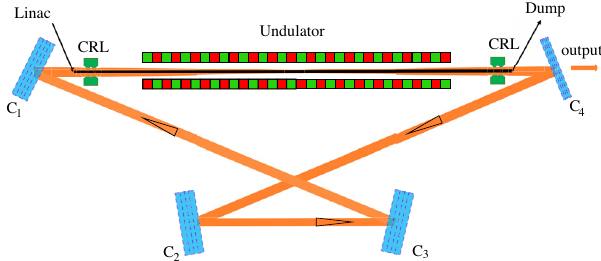
FIG. 11. A schematic XFELO configuration for the SHINE. Four diamond mirrors are used. The photon energy is 14.33 keV. C C C 1 , 2 ,and 3 are thick crystal to reach atotalreflection.Thex-ray coupled out from the downstream mirror C 4 which peak reflec- tivity reaches 87%.